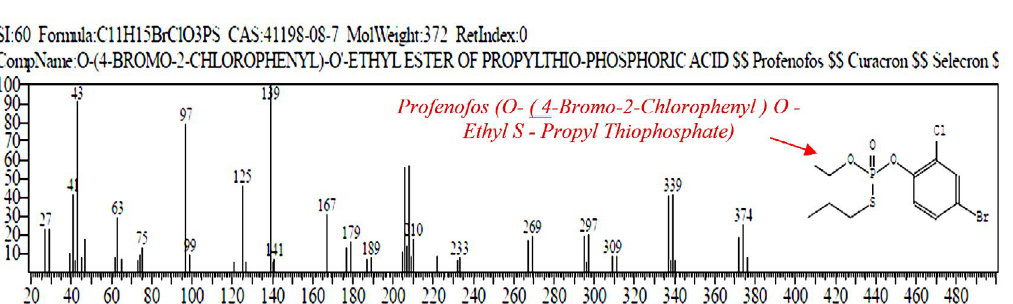
Fig. 7. The chromatogram and chemical structure of Butanedioic Acid Malathion [(Dimethoxyphosphinothioyl) Thio] at observation t = 96 hours